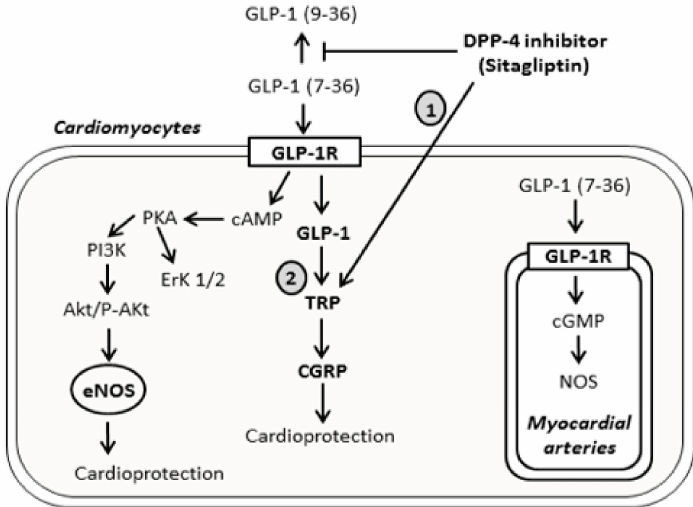
Figure 11. Schematic diagram showing the signaling pathways activated by the DPP-4 inhibitor sitagliptin, directly or upon binding to GLP-1 receptors. The diagram represents the traditional signaling mechanisms involved in cardioprotection, including cAMP/PKA, PI3K, Akt/P-Akt, ErK1/2, and cGMP, mediated NOS upregulation and e-NOS production. It also clarifies the novelty of this study (Upregulation of TRP channels and CGRP mediated by sitagliptin and GLP-1). Activation of TRP channels is either through the direct effect of DPP-4 inhibitor (1) , or through GLP-1R and GLP-1 activation (2). The arrow sign ( ) indicates mechanism’s activation, and the T bar sign ( ) indicates the inhibitory